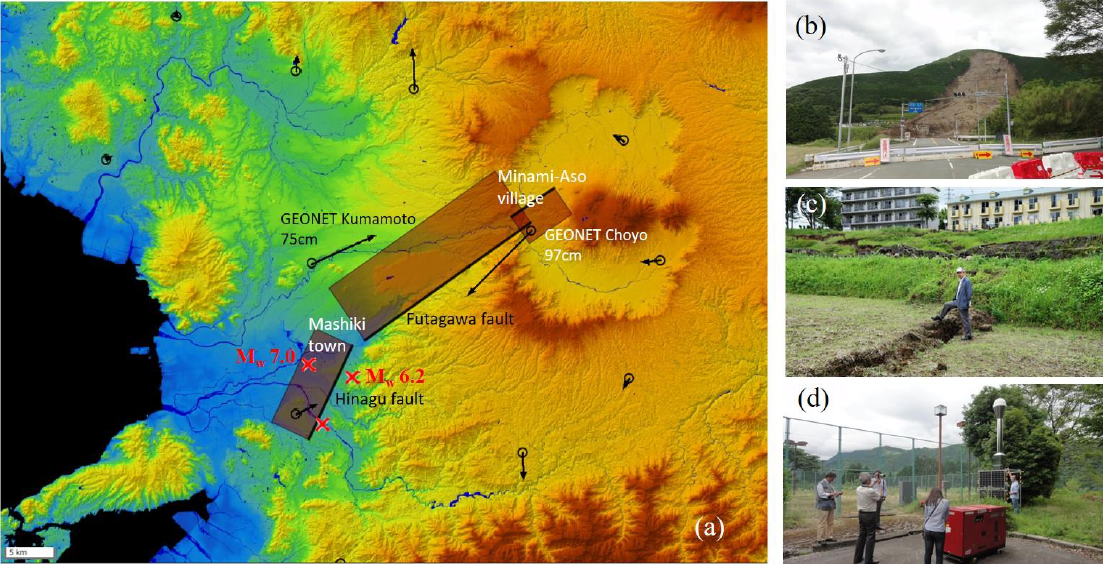
Figure 1. ( a ) Locations of the causative faults of the 2016 Kumamoto earthquake sequence, GNSS stations, and Minami-Aso village on a GSI map [34]. Three ground photos taken in a field survey by the authors on 16 June 2016; ( b ) the largest landslide near Kawayo; ( c ) surface faulting in Kawayo; ( d ) GEONET Choyo station, where the largest horizontal movement of 97 cm was recorded.